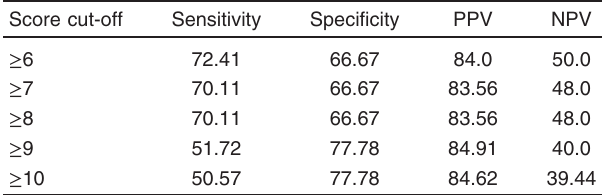
Table 4 Agreement (sensitivity, specificity, positive predictive value, and negative predictive value) for computed tomography scoring as a predictor for malignancy